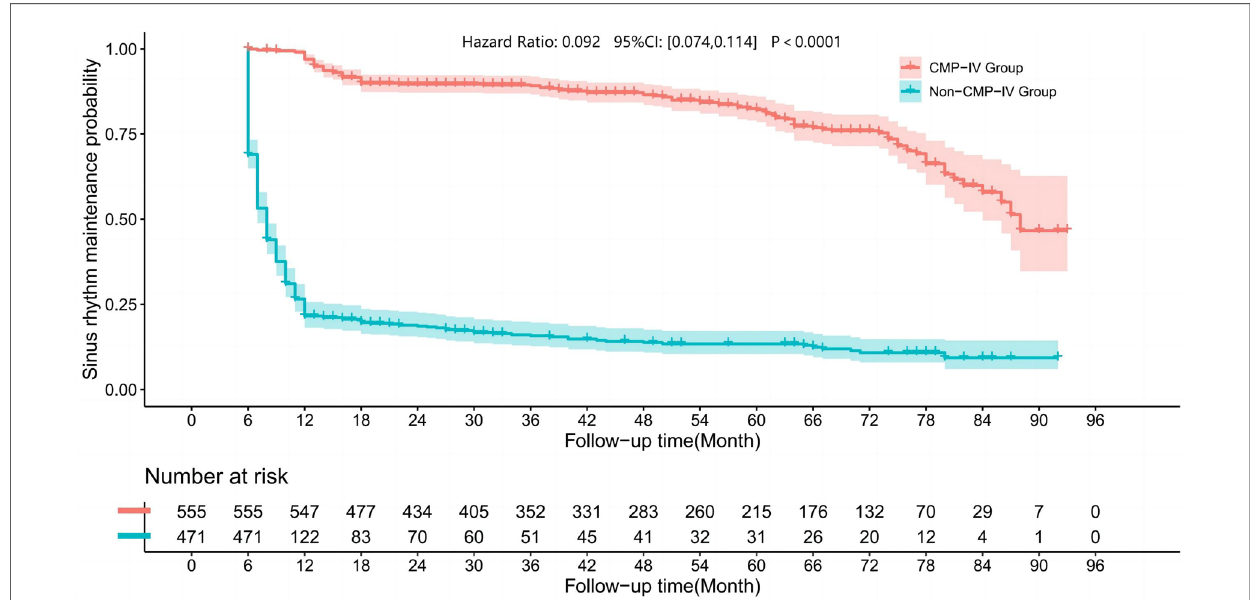
FIGURE 1 Kaplan – Meier curves were used to visualize the sinus rhythm maintenance rate in the two groups. The Log Rank rank sum test statistic for the comparison of survival time between the two groups was 673.932, indicating a signi fi cant difference in sinus rhythm maintenance rate between the CMP-IV group and the Non-CMP-IV group ( p <0.001). The median sinus rhythm maintenance time for the CMP-IV group was 88 months (95% CI: 84, NA) and for the Non- CMP-IV group was 8 months (95% CI: 7, 8). The hazard ratio for the Cox-Maze IV group compared to the Non-Cox-Maze IV group was 0.092 (95% CI: 0.074, 0.114). The follow-up time was plotted in months, and the number of patients at risk was shown below the graph.